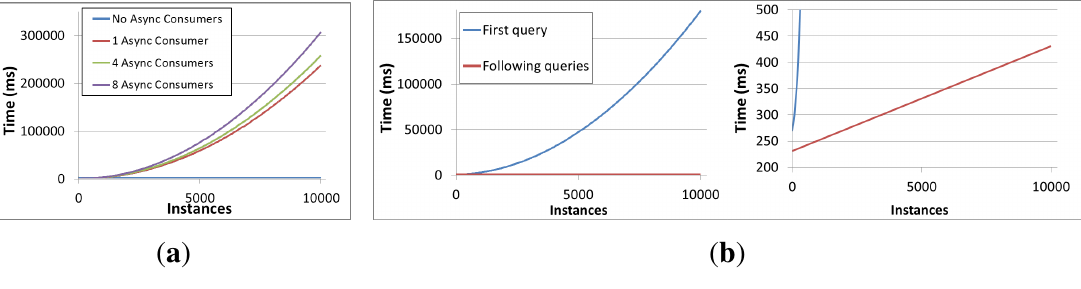
Figure 7. System performance in reasoning—Instance Adding and query times with Jena. ( a ) Adding times with different asynchronous consumer count; ( b ) Query times—First query after adding context and following